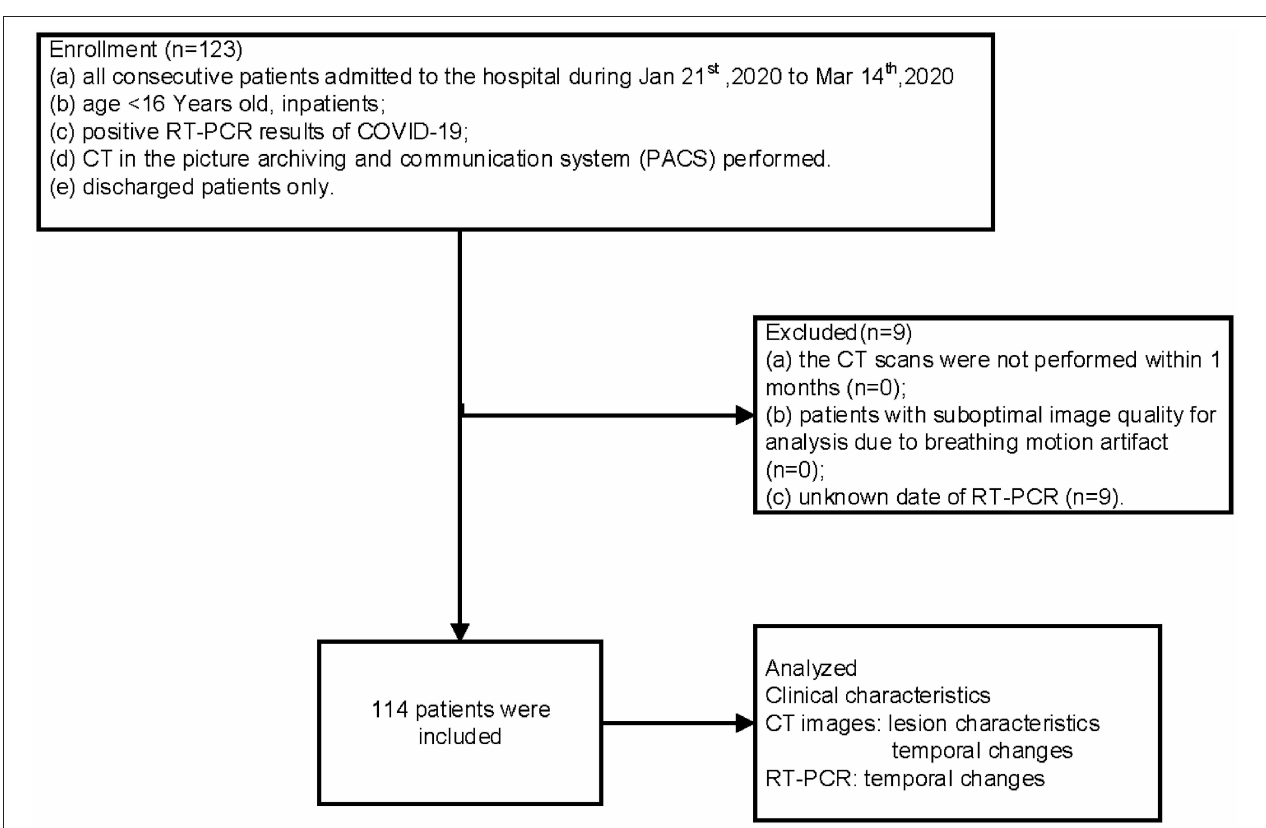
FIGURE 1 | Flow chart of this